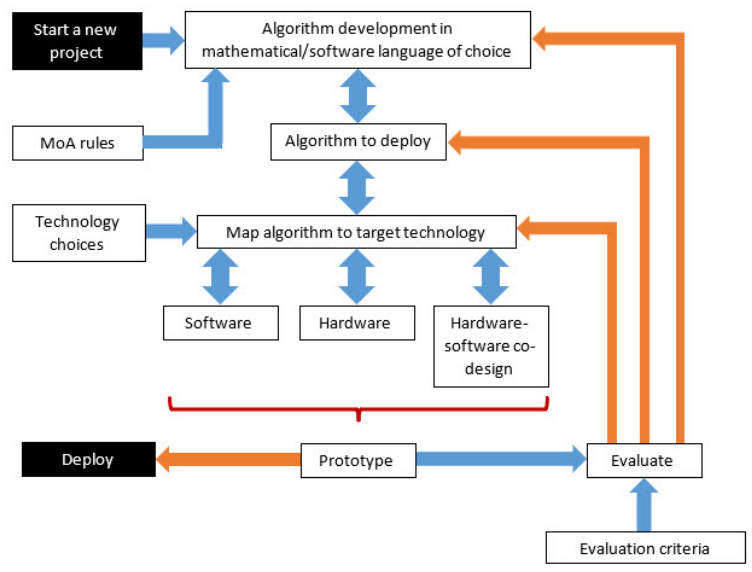
Figure 1. Concept to